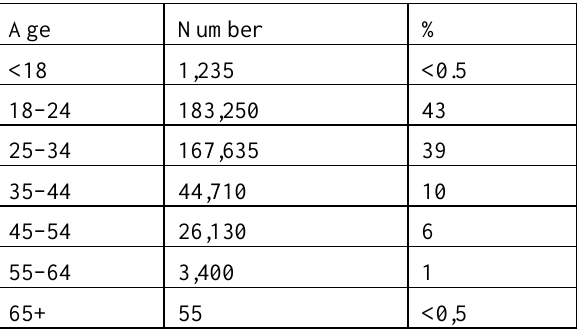
Table 2 . Age of registered workers on the UK